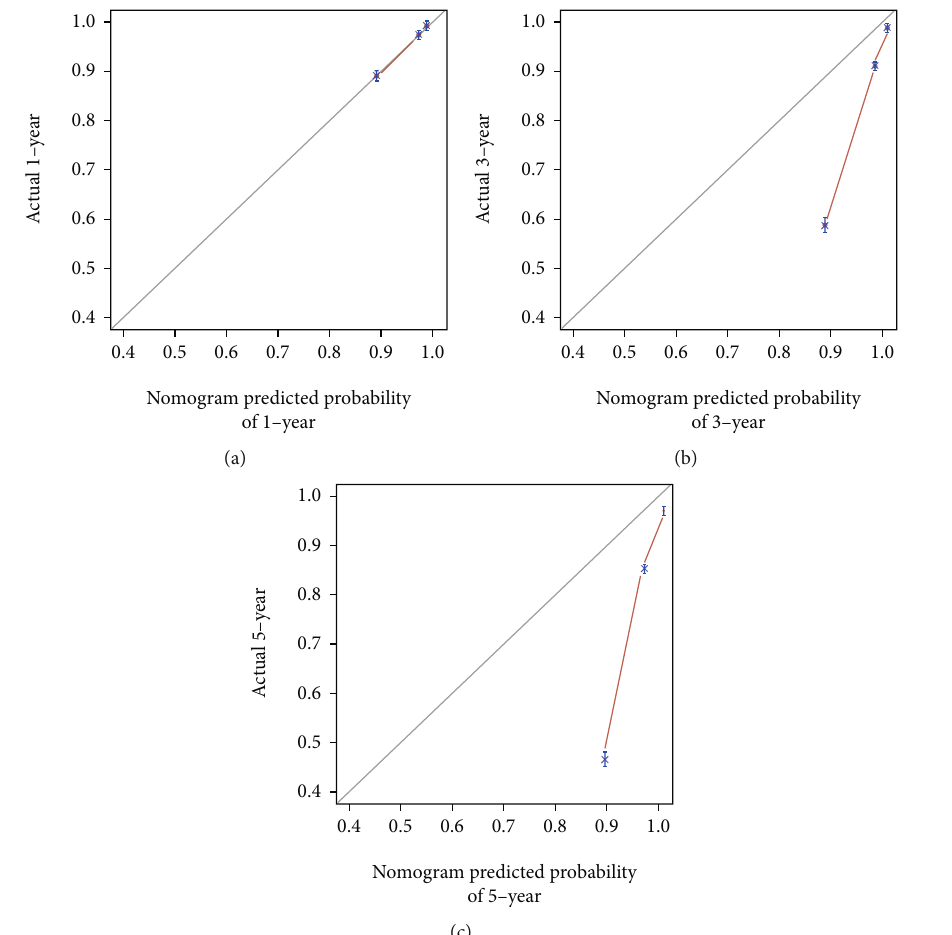
Figure 6: The calibration curves in the validation dataset (from left to right are the calibration curves for the prediction of survival in year 1, year 3, and year 5,